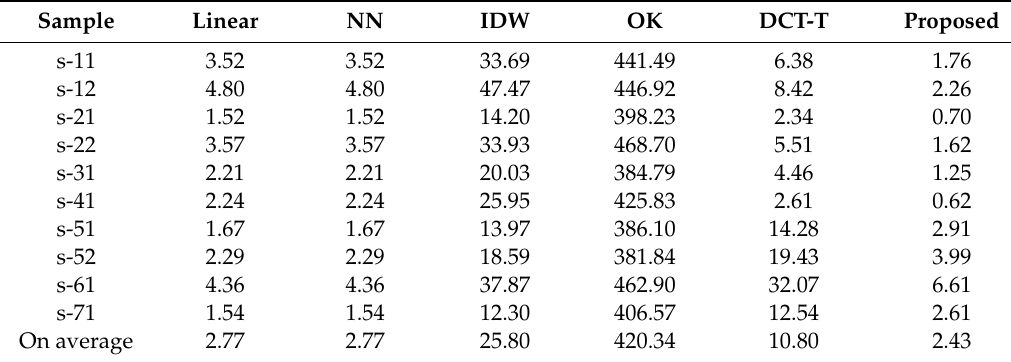
Table 6. Random access memory costs of the proposed method and the other interpolation methods on the public datasets (unit: